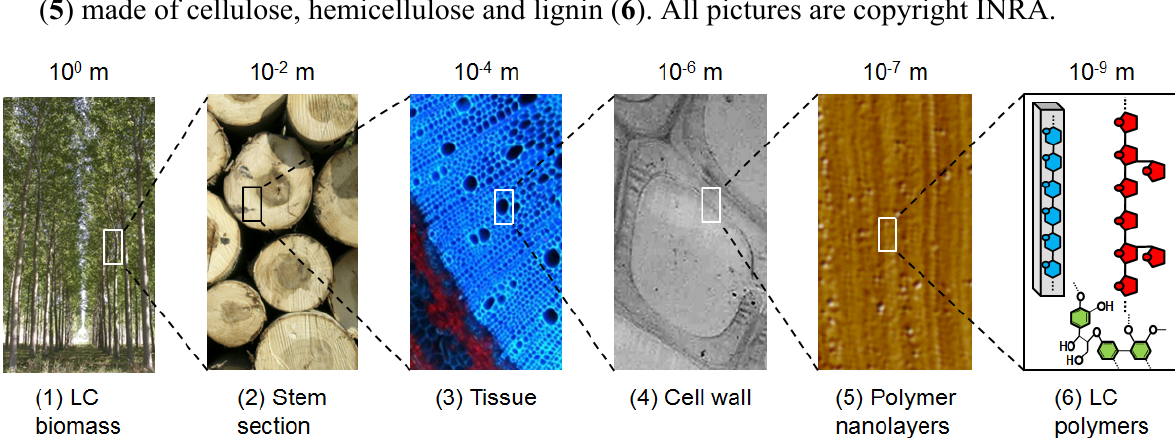
Figure 1. Multi-scale architecture of the PCW. Macroscopic biomass (tree) ( 1 ) contains different organs; among them stem ( 2 ) accounts for the largest proportion in weight. Stem is formed by tissues ( 3 ) composed by cells whose walls ( 4 ) consist of a matrix of LC nanolayers ( 5 ) made of cellulose, hemicellulose and lignin ( 6 ). All pictures are copyright